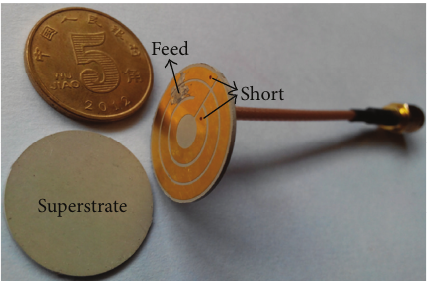
Figure 7: Photograph of the fabricated implantable antenna.